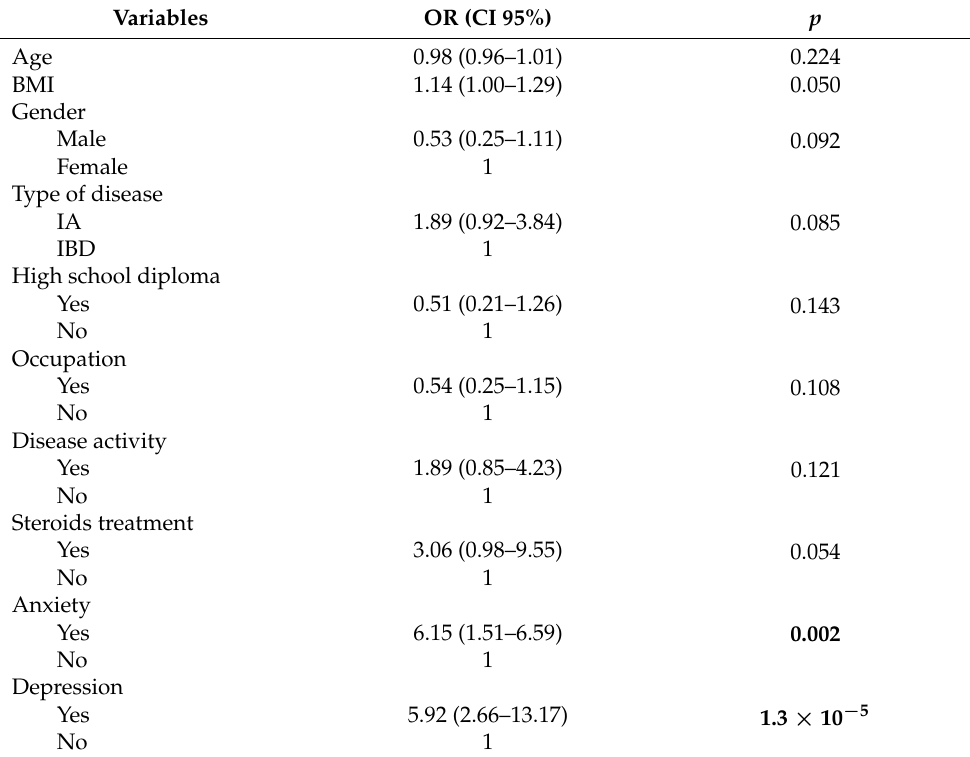
Table 3. Multivariable logistic regression model for fatigue in